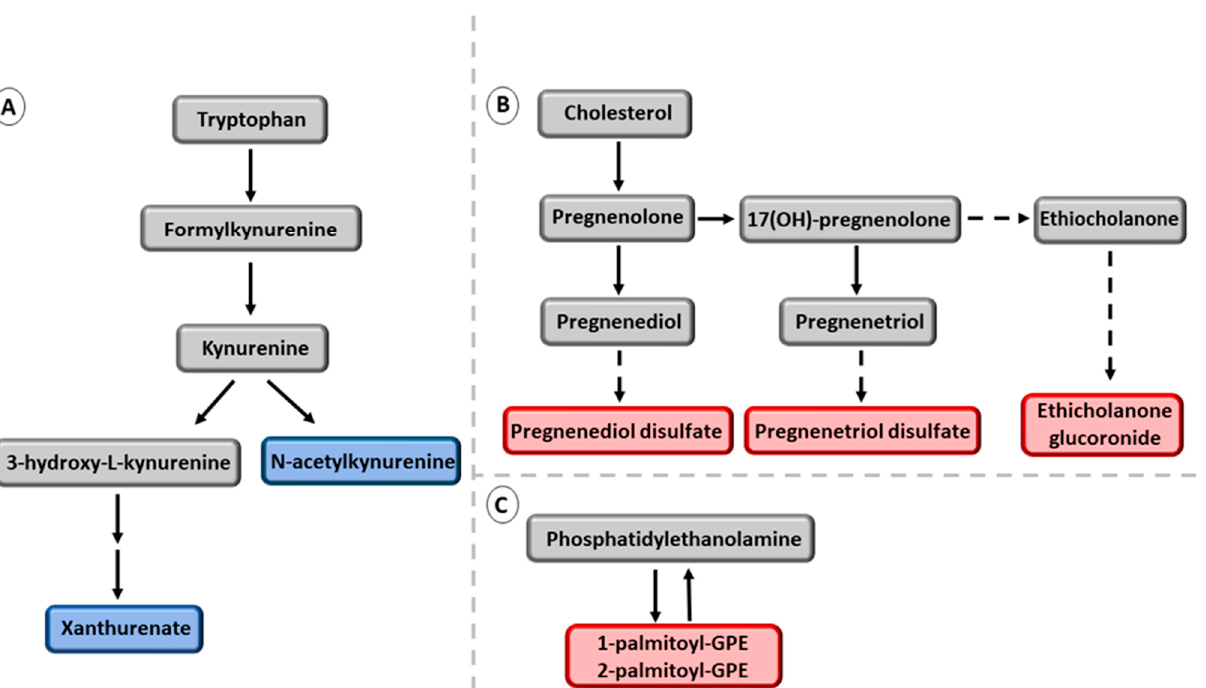
Figure 4. Novel metabolites associated with PPP1R3B rs4841132-A in men with NAFLD. ( A ) downstream metabolites of the tryptophan pathway. ( B ) metabolites belonging to the pregnenolone pathway. ( C ) metabolites belonging to the phosphatidylethanolamide pathway. Red color indicates increased and blue color decreased concentration of the metabolites. Grey color indicates that these metabolites were not significantly associated with PPP1R3B rs4841132-A.